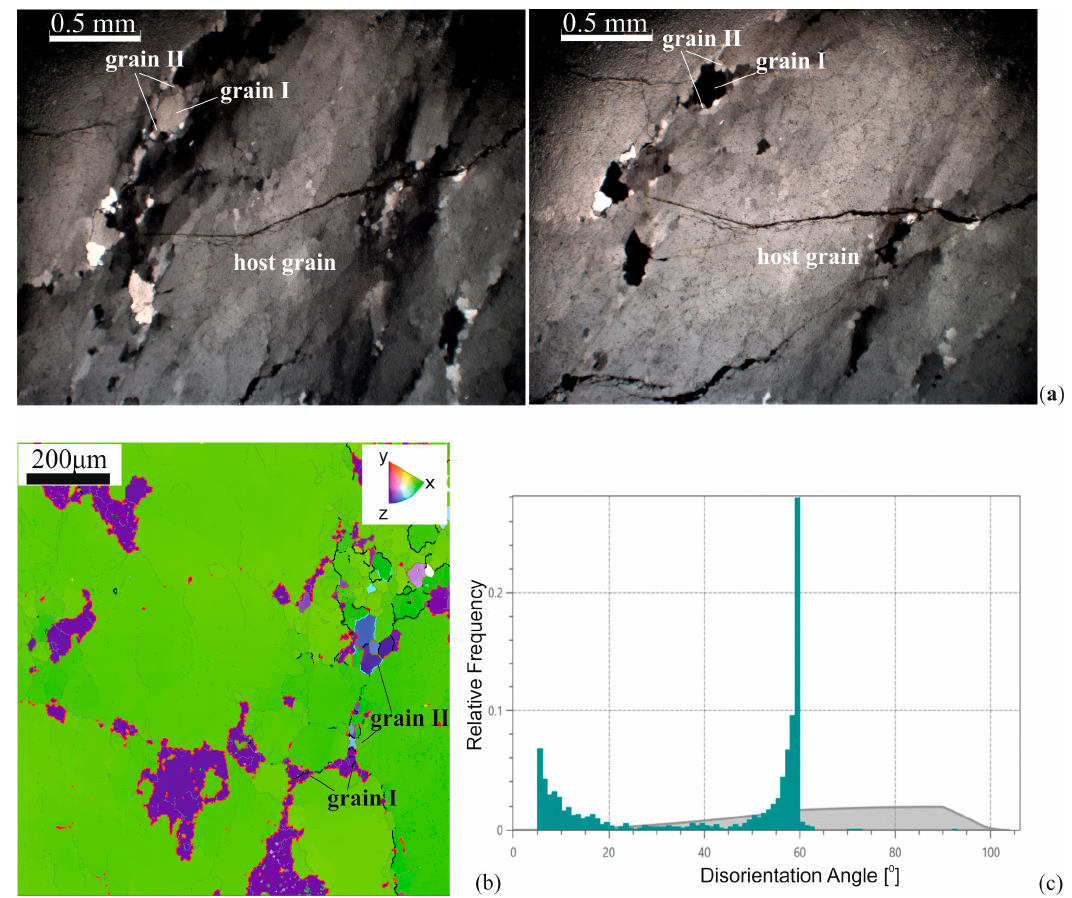
Figure 9. Features of the microstructure of vein quartz type D: ( a ) optical micrography with recrystallized quartz; ( b ) the processed EBSD band contrast (BC) + inverse pole figure (IPF) map with the color coded boundary indicating the angle of boundary misorientation and recrystallization grains (grain II) are adjacent to the purple domain (grain I); and ( c ) the disorientation angle distribution and theoretical curve (gray color).